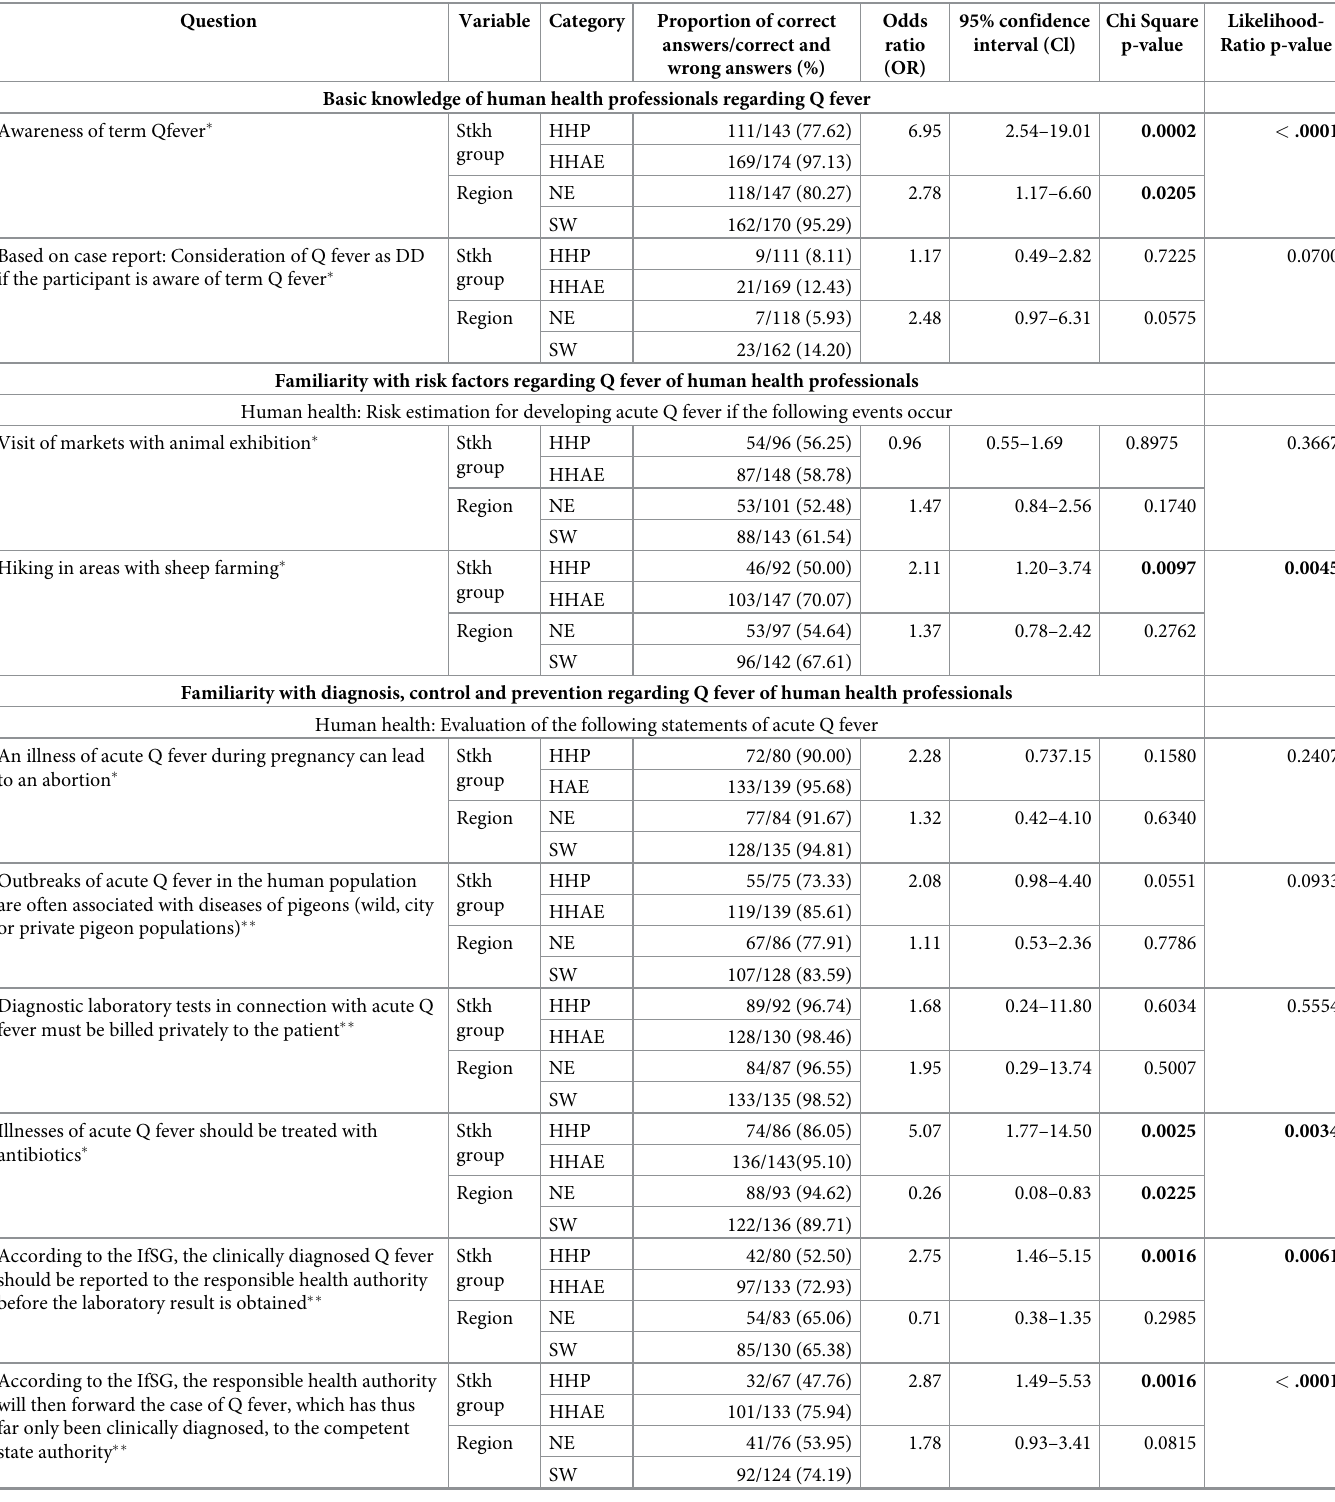
Table 3. Multivariable logistic regression analysis of the proportion of correct answers of human health professionals (online